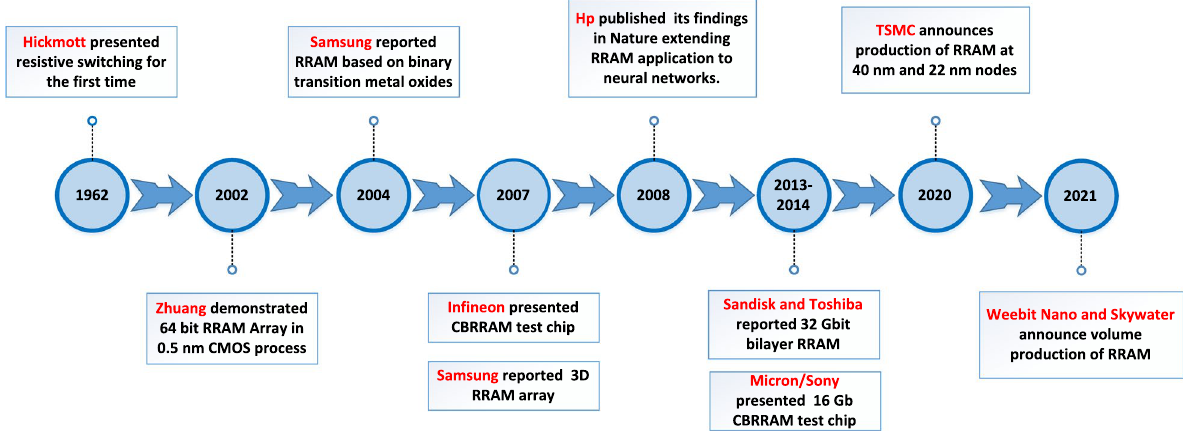
Fig. 2 History of development RRAM from 1962 to